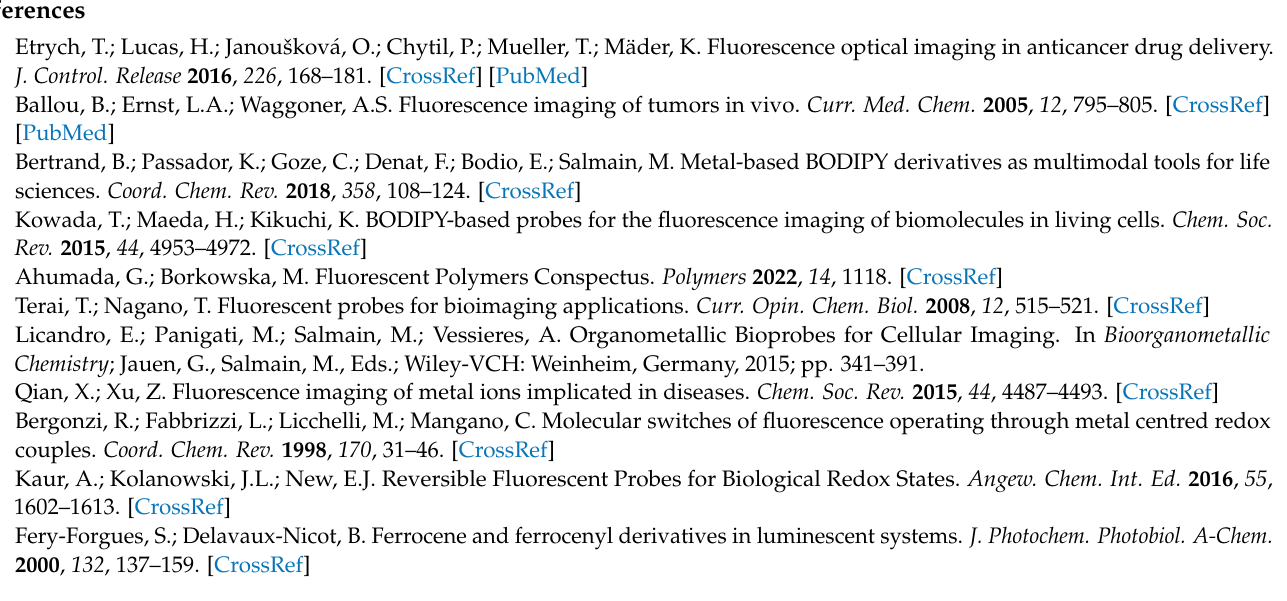
Figure S3: 1 H and 13 C NMR spectra of 3a ; Figure S4: 1 H and 13 C NMR spectra of 3b